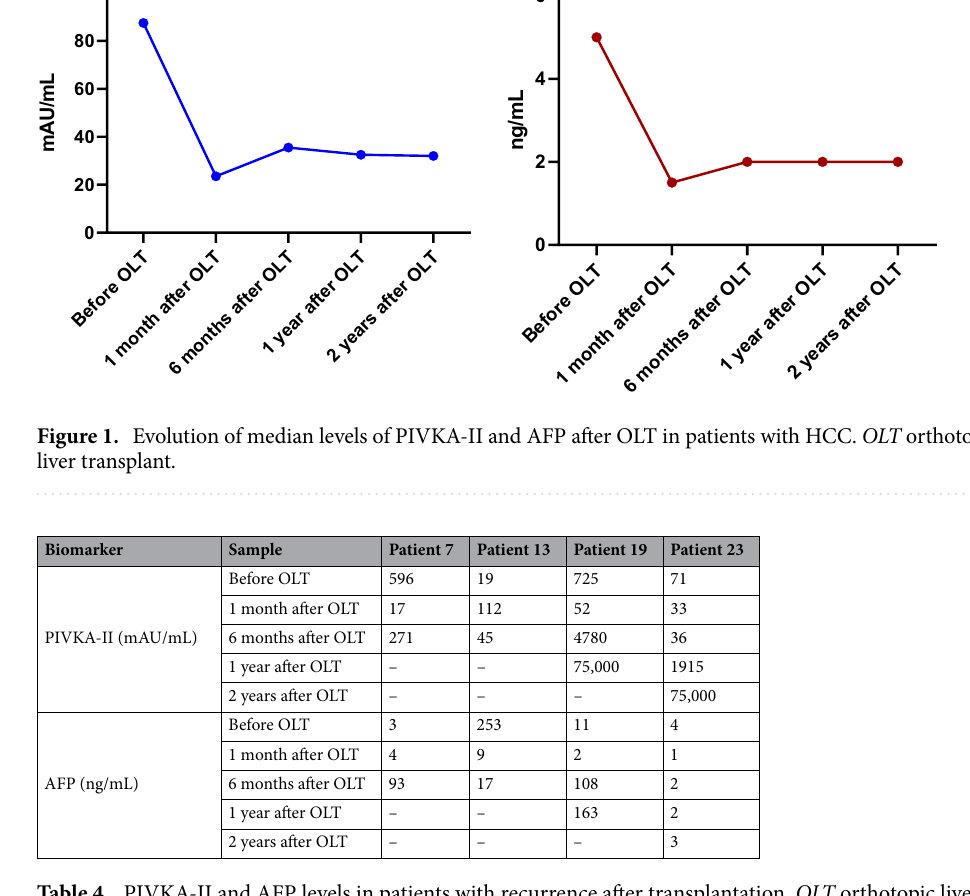
Table 4. PIVKA-II and AFP levels in patients with recurrence after transplantation. OLT orthotopic liver